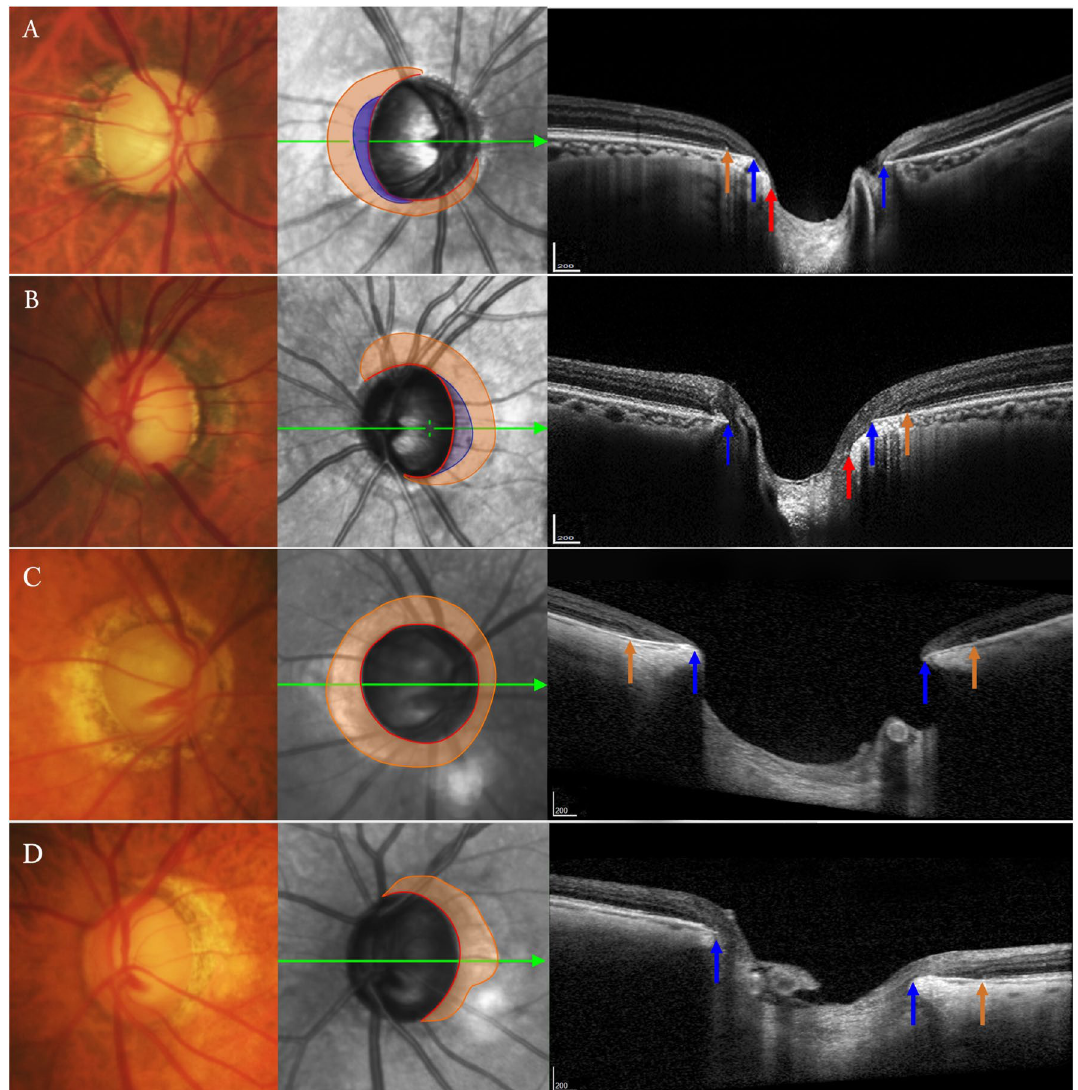
Figure 1. Illustration of measurement of parapapillary beta and gamma zones in bilateral eyes of glaucoma patients. ( A , B ) The size of parapapillary beta zone (orange shadow) and parapapillary gamma zone (blue shadow) was similar between the severe right eye and the moderate left eye in a POAG patient. ( C , D ) The severe right eye showed a concentric shape of parapapillary beta zone in a PACG patient, while the moderate left eye showed a relatively smaller parapapillary beta zone. Red arrow/line: optic disc margin; Blue arrow/line: the end of Bruch’s membrane; Orange arrow/line: the end of Multivariate linear regression analyses were also performed to investigate factors related to parapapillary gamma zone area. In multivariate analysis model for gamma zone area, parameters including beta zone area (P = 0.099), MD value (P = 0.825), age (P = 0.817), IOP (P = 0.630), glaucoma type (P = 0.592), and mean cpRNFL thickness (P = 0.563). In final model, a larger gamma zone area was only associated with axial length (P < 0.001). Beta zone subtype according to angular extent. the temporal shape group and 45 eyes were in the concentric shape group. The proportions of different shape of parapapillary beta zone showed no significant difference between eyes with PACG and POAG ( P > 0.05, Table 1). Compared with the concentric shape group, the temporal shape group showed a significant younger age ( P < 0.001), smaller beta zone area ( P < 0.001) and longer axial length ( P = 0.039), while IOP, MD value, cpRNFL, gamma zone area showed no significant difference ( P > 0.05). In multivariate logistic analysis of the whole group, the factors associated with concentric or temporal shape were age (OR = 1.081, P = 0.001) and MD value (OR = 1.064, P = 0.034) (Table 4). Variables were further compared between temporal and concentric shape of beta zone in the PACG group and POAG group, respectively. In the PACG group, temporal shape of beta zone eyes showed a significant younger